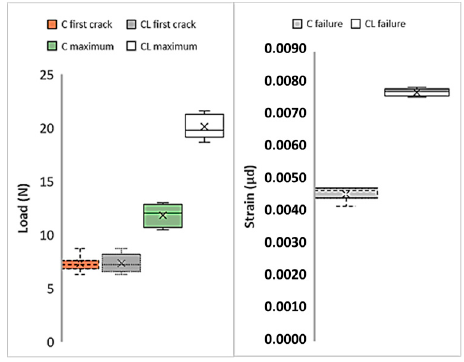
Figure 13. Variations of the critical points of the tensile tests for M120 matrix composites.